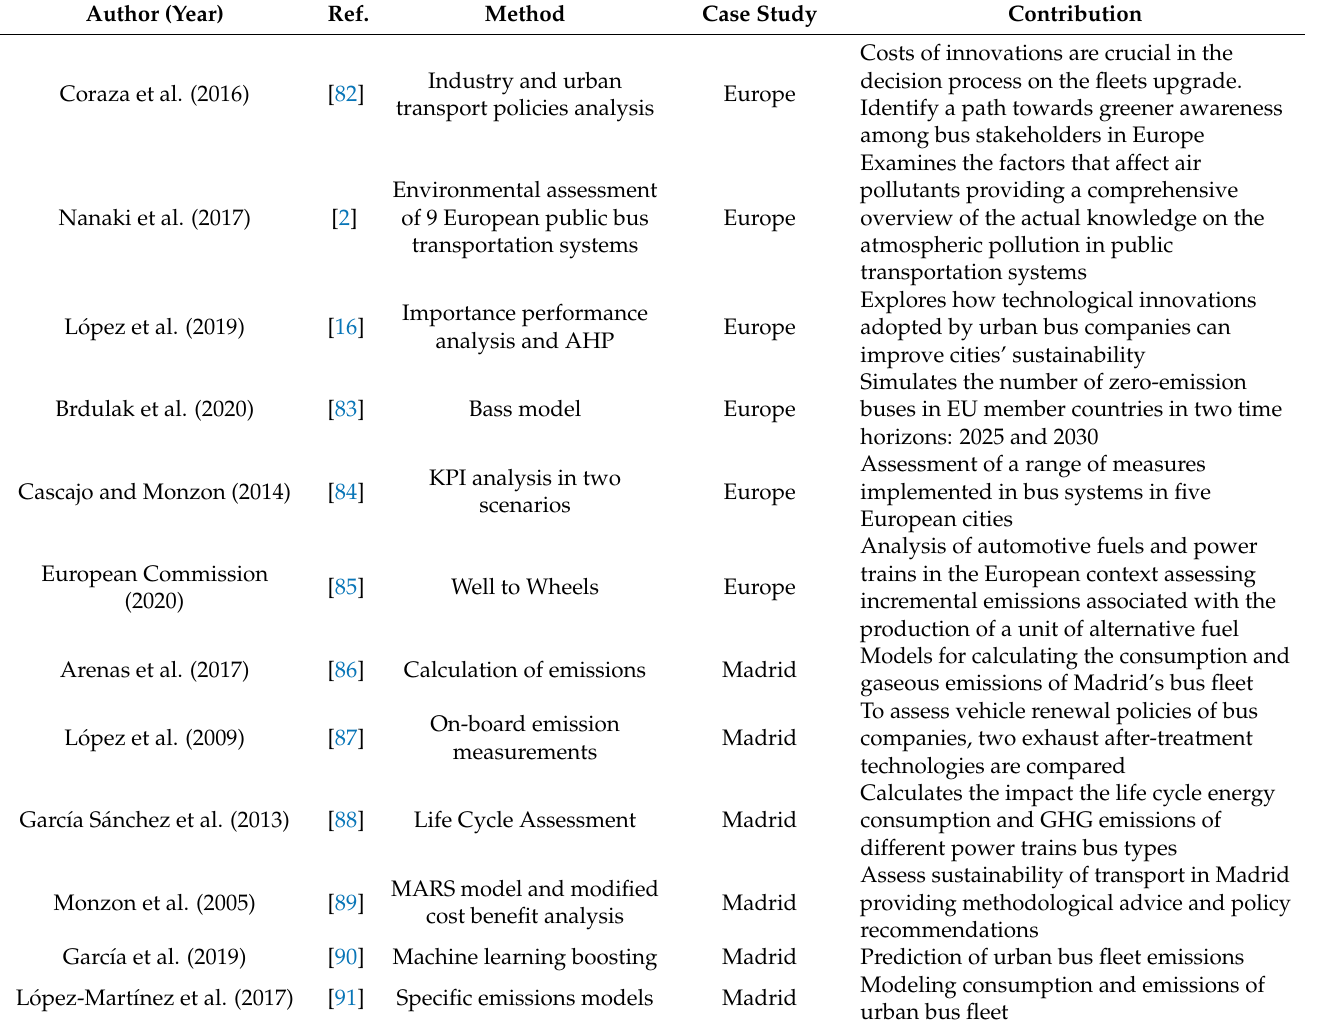
Table 5. Literature review on the situation in Europe, and specifically in the city of